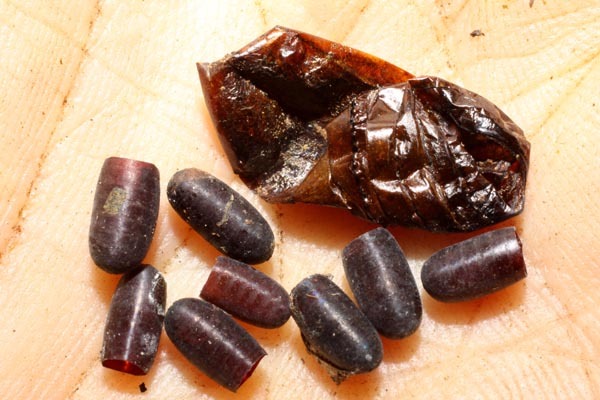
Puparia of Hyphantrophaga
danausophaga voucher n. DHJPAR0034375, reared from Danaus
plexippus voucher n. 09-SRNP-35341. Image voucher n. DHJ470083.jpg